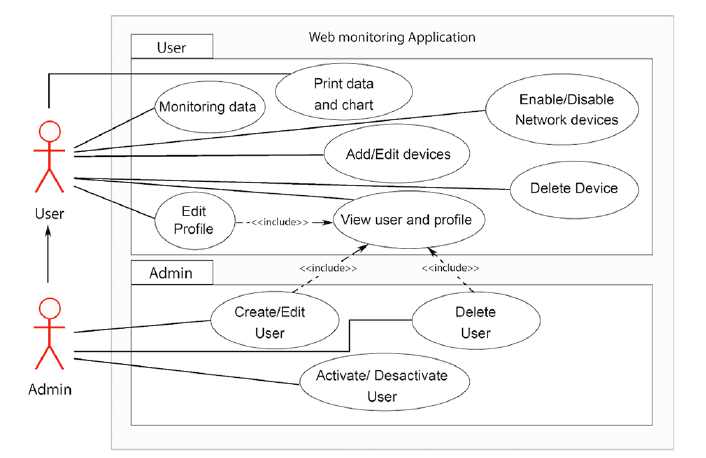
Figure 12. Web application use case